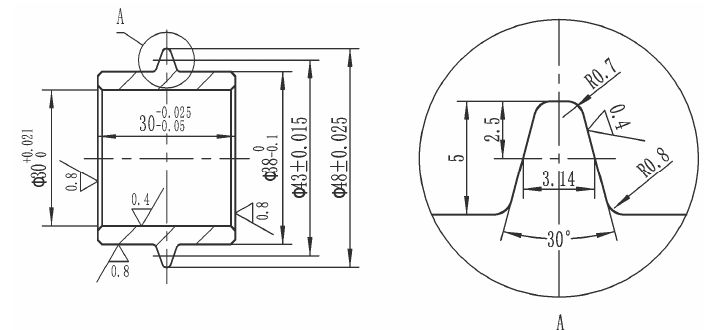
Figure 4. Dimensions and tooth detail of the roller (dimensions in mm).